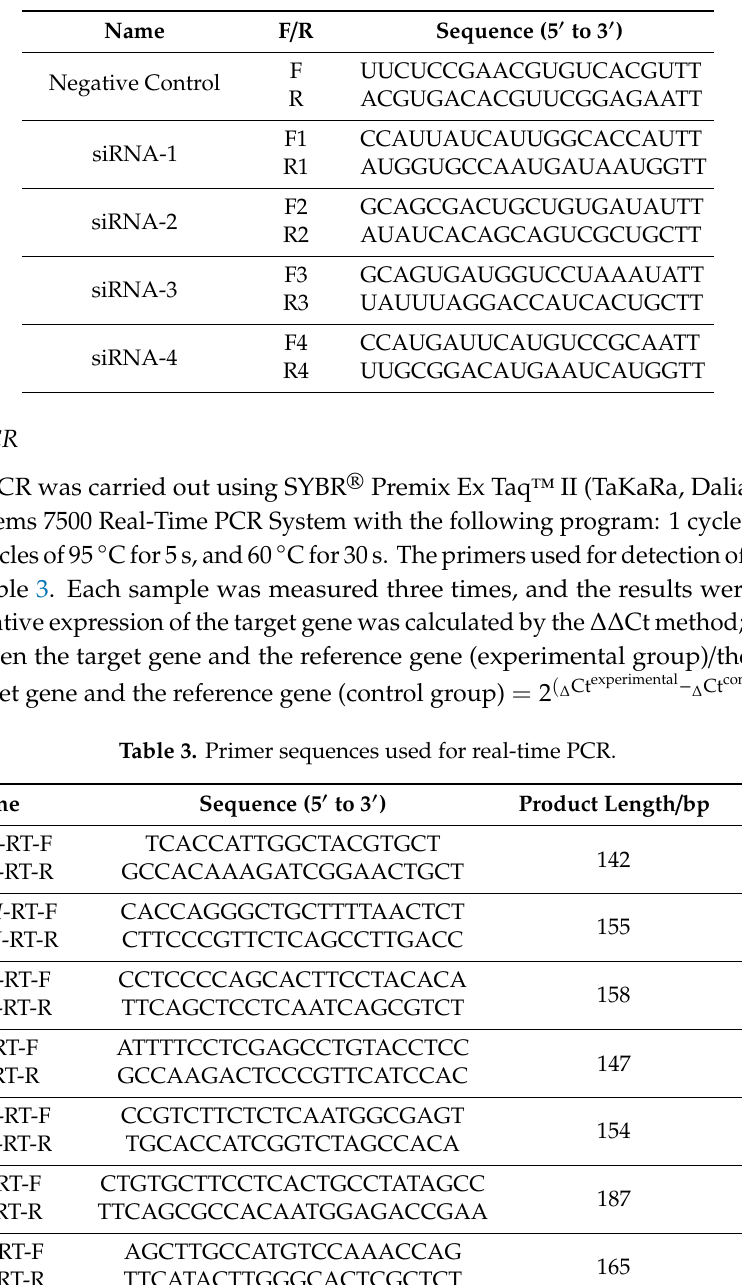
Table 2. The primer sequences of Slc7a11 siRNA primers.